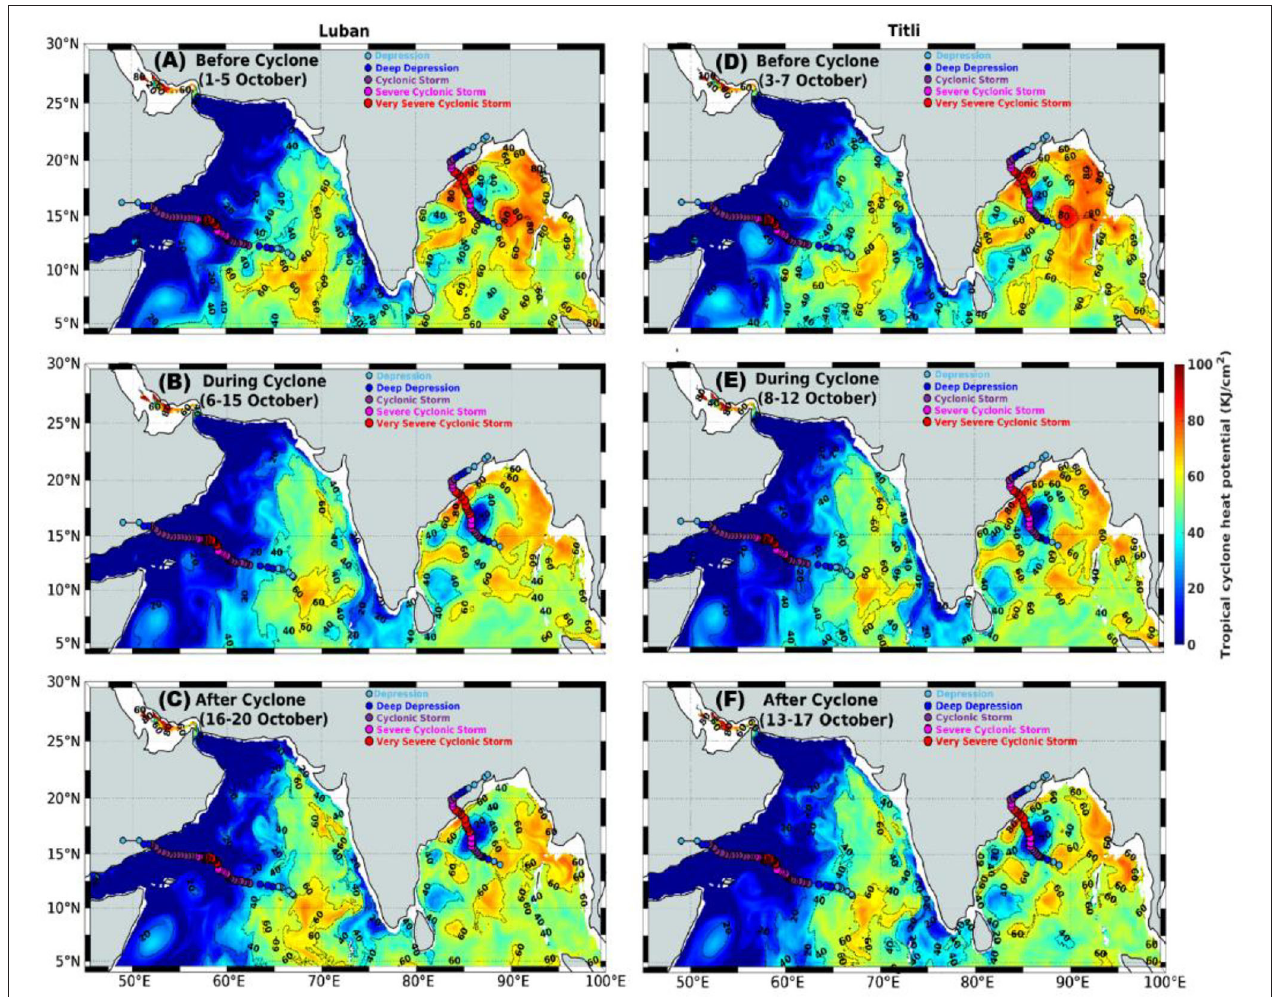
FIGURE 3 | Spatial distribution of the tropical cyclone heat potential (TCHP, kJ/cm 2 ) before (A,D) , during (B,E) , and after (C,F) cyclones Luban (A–C) and Titli (D–F) , superposed with cyclone